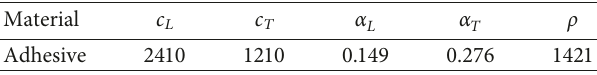
Table 2: Wave velocity in m/s, attenuation in Np/ λ , and density in Kg/m 3 .